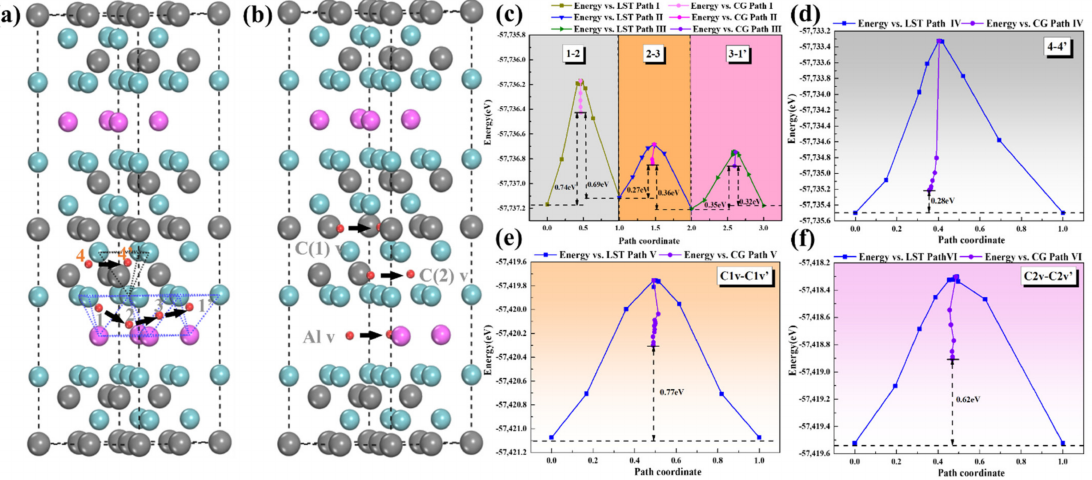
Figure 10. Diffusion of H in Nb 4 AlC 3 ( a , b ); energy profiles and diffusion energy barrier (eV) ( c – f